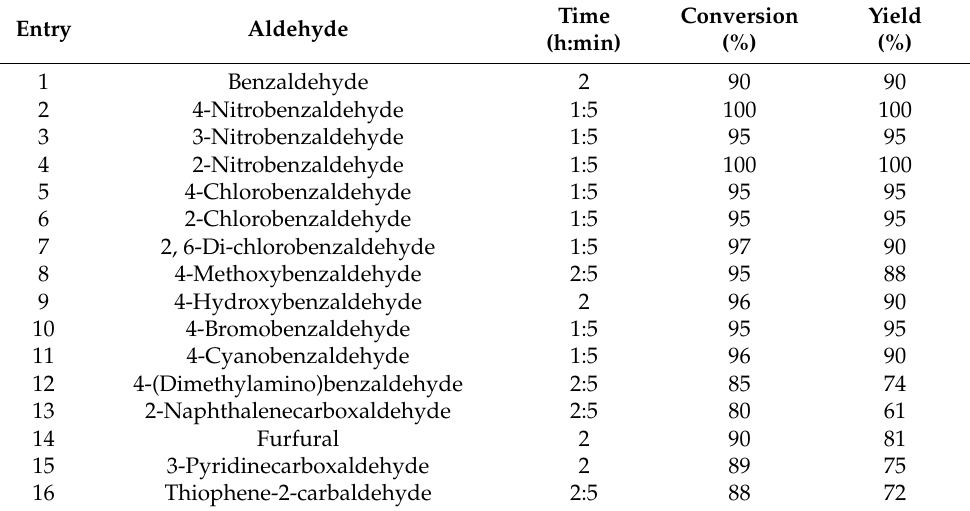
Table 3. Synthesis of 4 H -benzo[ b ] pyrans a .